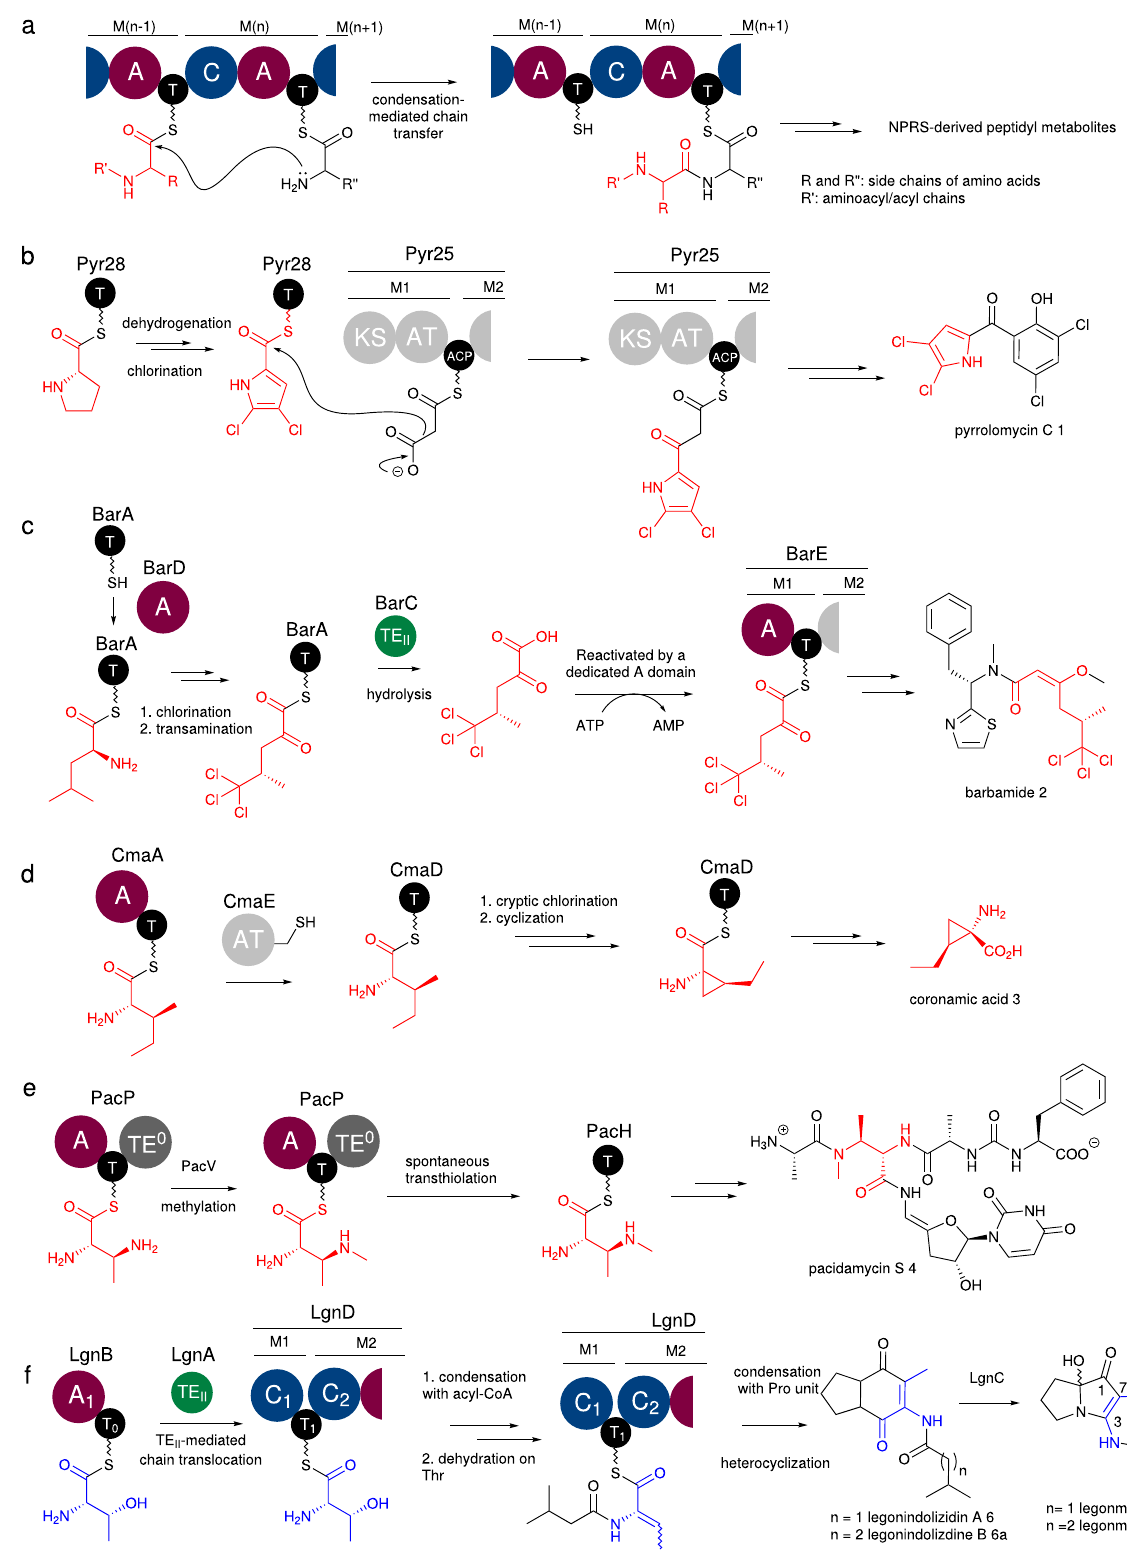
molecular weights of 65 kDa for LgnB and 207 kDa for LgnD as observed in SDS page analysis (Supplementary Fig.